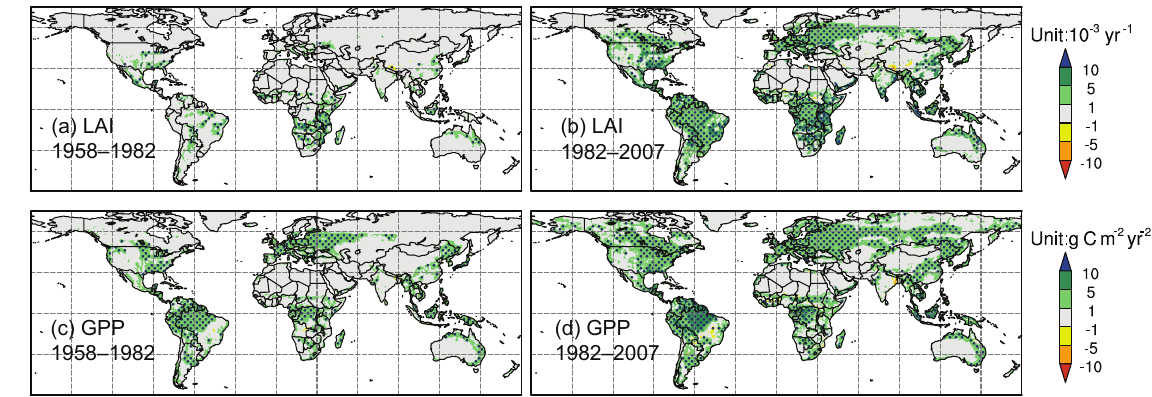
Figure 8. CO 2 effect on the trends (shaded) of (a, b) LAI (units: 10 − 3 yr − 1 ) and (c, d) GPP (units: gCm − 2 yr − 2 ). Panels (a, c) are for 1958–1982 and (b, d) are for 1982–2007.